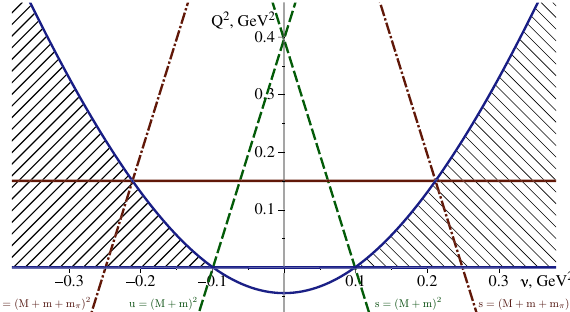
Fig. 4 Physical and unphysical regions of the kinematical variables ν and Q 2 (Mandelstam plot) for the elastic muon–proton scattering. The hatched blue region corresponds to the physical region, the dashed green lines give the elastic threshold positions, the dashed-dotted red lines give the inelastic threshold positions. The horizontal red curve indicates the line at fixed Q 2 along which the dispersive integrals are evaluated. For Q 2 (cid:3) 0 . 4 GeV 2 ( Q 2 (cid:3) 1 GeV 2 ) the s- and u-channel elastic (pion–nucleon) cuts